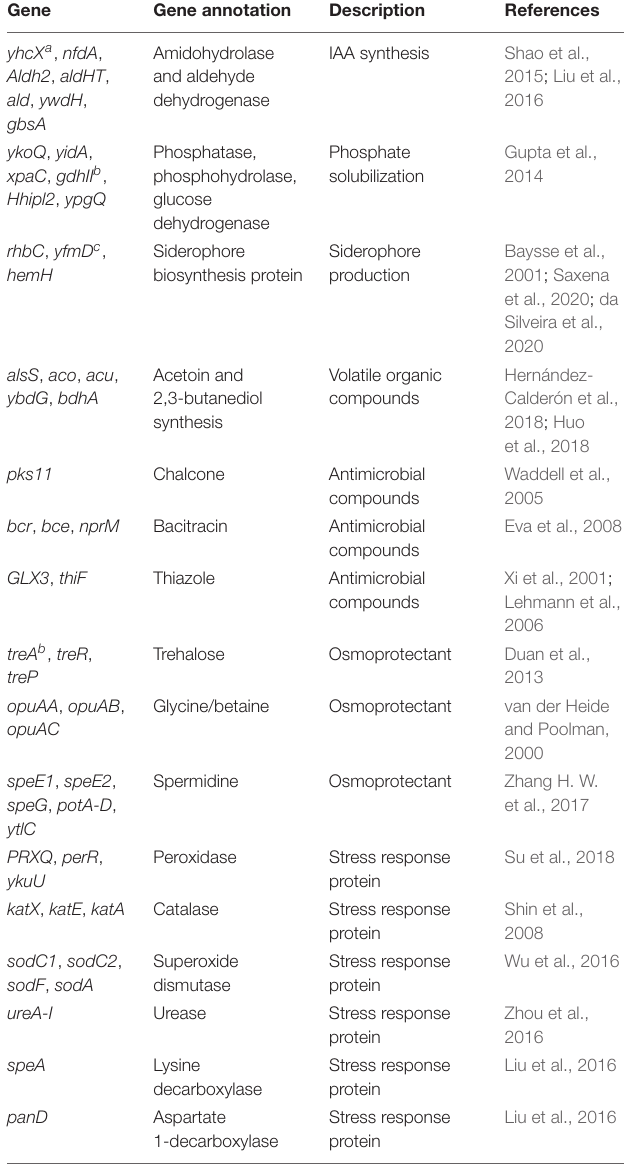
TABLE 3 | Potentially beneficial genes of B. megaterium HGS7 for plant